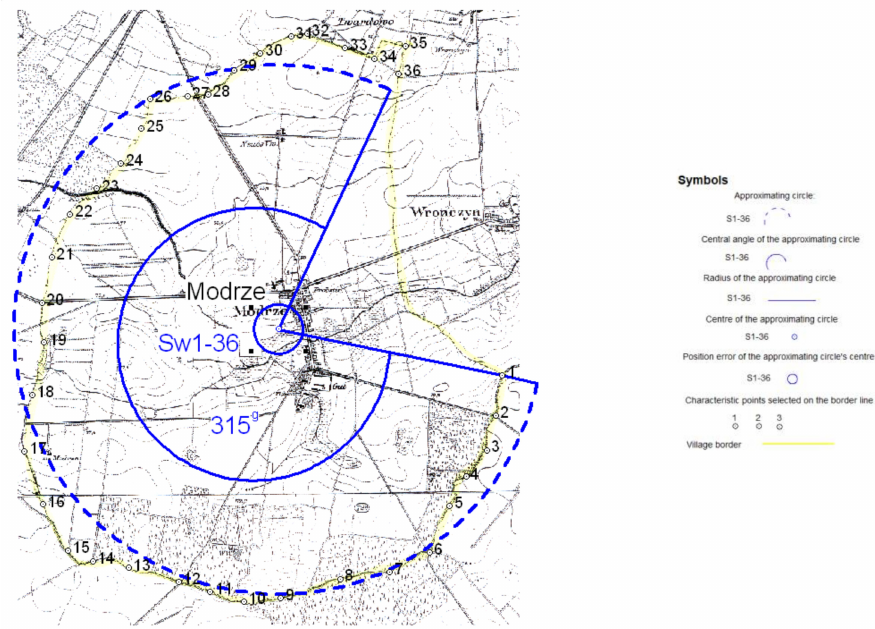
Figure 15. Modrze. Course, position and error of the approximating circle: Sw 1—36—approximation of points 1—36. Scale